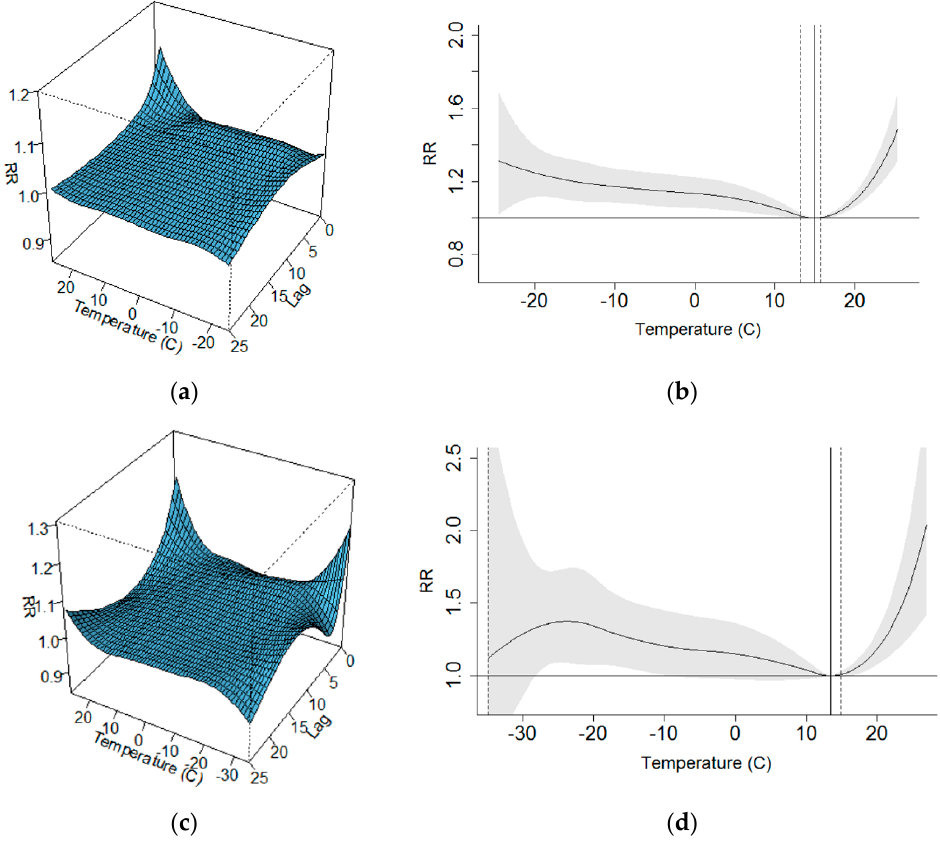
Figure 4. Outcomes of DLNM for hospital districts HD1 and HD12 with a model version with 25-day delayed temperature effects: ( a , c ) 3D visualizations of the relative risk of mortality as a function of temperature and lag; ( b , d ) overall relative risk (curves) with 95% CI (shaded). The point of minimum mortality temperature is indicated with a solid vertical line (95% CI, dotted vertical lines). HD1 is in southern and HD12 in eastern-central Finland. Modelling with fixed number of knots: 3 for temperature and 2 for lag.